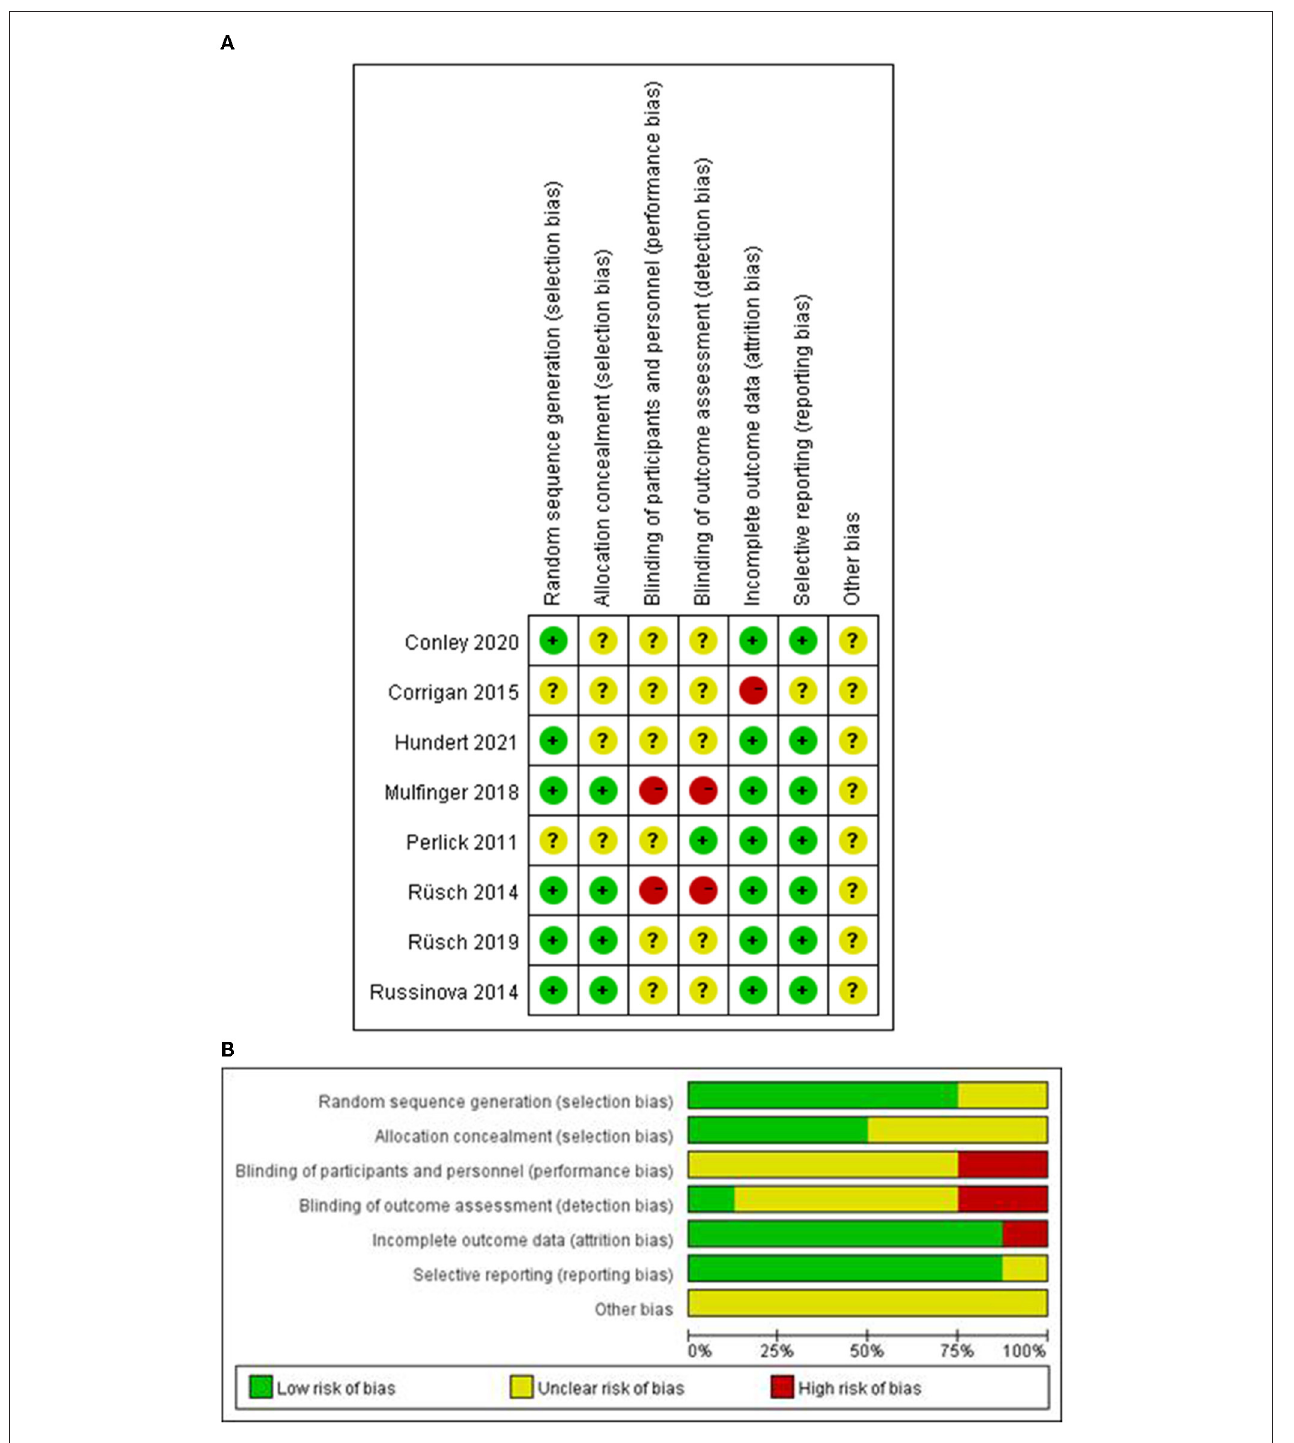
FIGURE 2 | Risk of bias